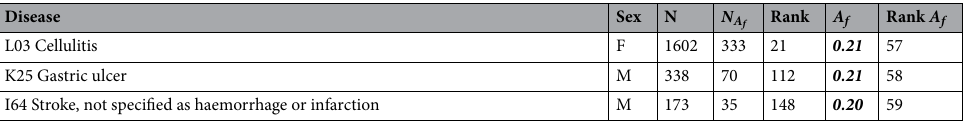
Table 1. Attributable fractions A f for both smoking and BMI are estimated with Eq. (10), ranked, and listed if A f ≥ 0.2 . Colours: A f ≥ 0.5 (bold), 0.5 > A f ≥ 0.35 , 0.35 > A f ≥ 0.2 (italics). Sex: diseases in males (M) or females (F), N : total cases, N A : attributed cases. f